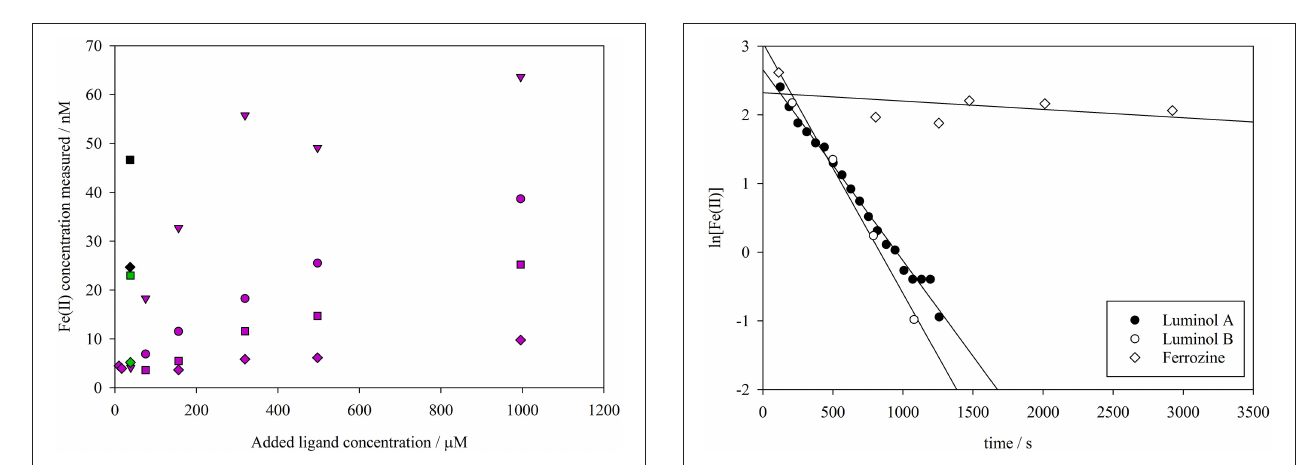
FIGURE 3 | Comparison of Fe(II) concentrations in aged river water determined spectrophotometrically using the synthetic ligands ferrozine (purple), ferene (green), and TPTZ (black). A varying ligand concentration, and time interval between ligand addition and absorbance measurement (diamonds 2 min, squares 80min, circles 140min, triangles 20h), was used.